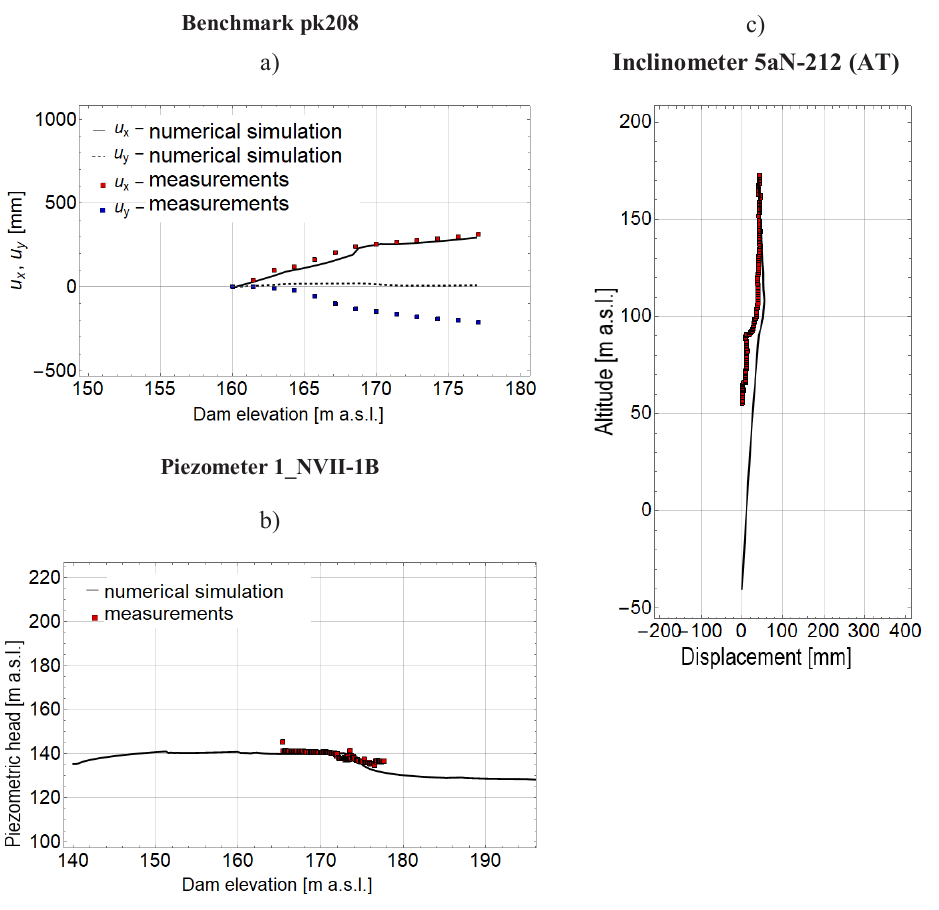
Figure 8: Exemplary calibration results: a) benchmark, b) piezometer, and c) inclinometer.